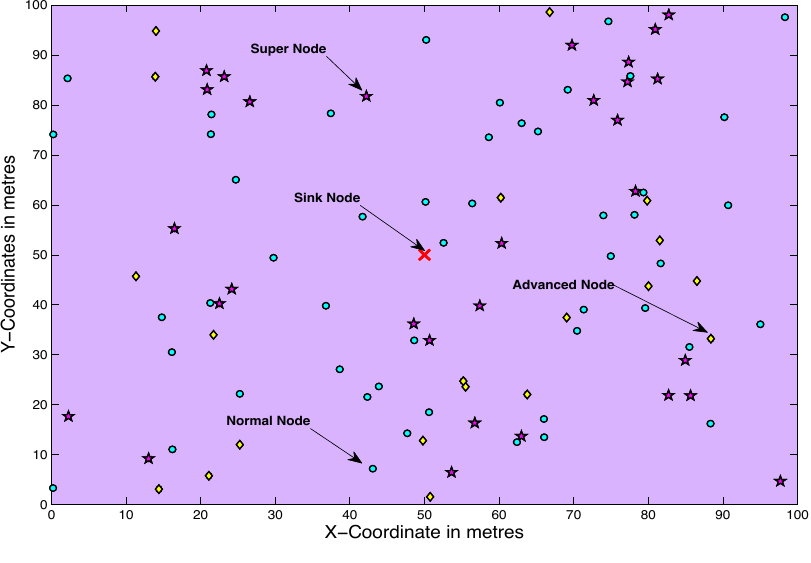
Figure 2. A heterogeneous wireless sensor